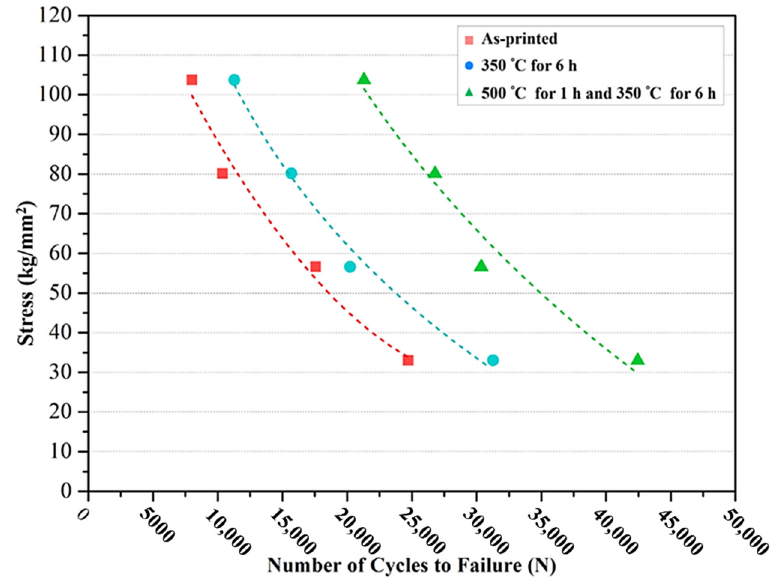
Figure 8. S–N curve of the SLM Al–Mg–Sc–Zr alloys.